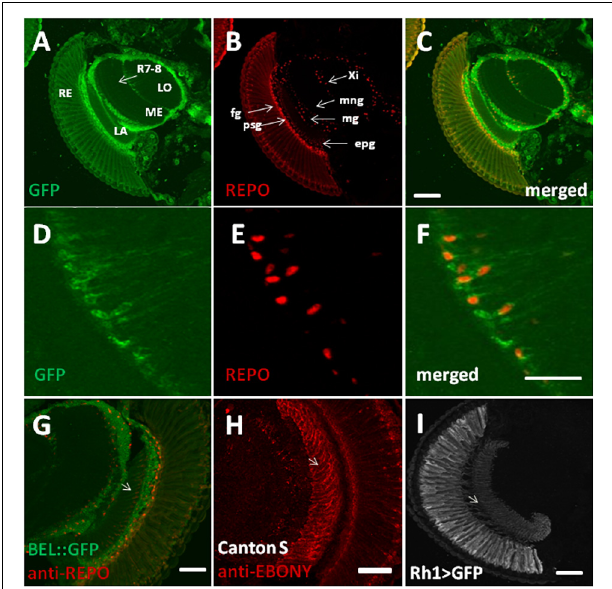
FIGURE 3 | BELLE localizes in the visual system of Drosophila melanogaster . Confocal images of horizontal cryosection of adult brain expressing BELLE fused with green fluorescent protein ( bel::GFP ). Anti-REPO was used to label all glia nuclei. (A) BEL::GFP signal is localized in the optic neuropils: lamina (LA), medulla (ME), and lobula (LO). Weak signal is visible in R7 and R8 photoreceptor terminals (R7-8) in the medulla. Signal in the retina (RE) is probably due to autofluorescence. (B) Anti-REPO staining allowed recognized different glia types: fenestrated glia (fg), pseudocartridge glia (psg), epithelial glia (epg), medulla glia (mg), marginal glia (mng), and inner chiasm glia (Xi). (C) Merged signal showed localization of BELLE in glial cells. Bar 50 µ m. (D–F) Higher magnification of inner chiasm glia showed that BELLE is localized mostly in the cytoplasm. Bar 20 µ m. (G–I) Localization of BELLE in the first optic neuropile, called lamina, analyzed on confocal images of horizontal cryosection of adult brain. Bar: 50 µ m. (G) Anti-GFP and Anti-REPO immunostaining showing that BEL::GFP signal is higher in the distal lamina (close to retina), where interneurons cell bodies are located. Weak labeling is also visible across the lamina, forming regular columns. Glia nuclei staining overlaps with observed BELLE location, suggesting that this signal originates from epithelial glia. (H) Section of wild-type CantonS brain stained with anti-EBONY to label epithelial glial cells in the lamina and their specific columnar shape (see Richard et al., 2002). (I) Anti-GFP staining on section of Rh1 > GFP brains showing R1–R6 photoreceptors terminals in the lamina.